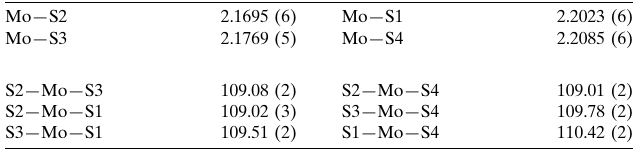
Selected geometric parameters (A˚ , (cid:3) ).